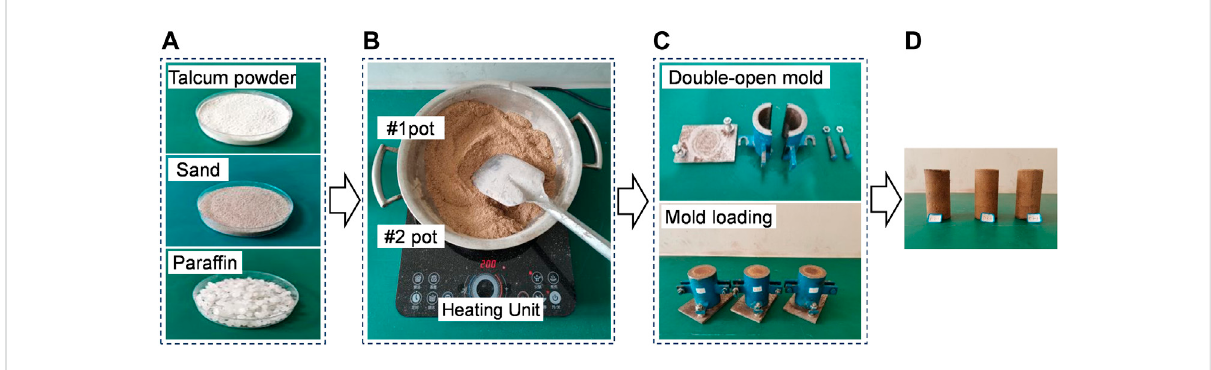
FIGURE 3 Schematic of the production process of similar material specimens. (A) Raw materials, (B) thermostatic heating, (C) test piece forming, and (D) test piece.